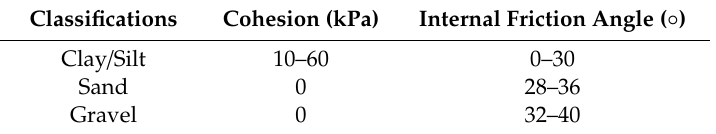
Table 1. Orders of magnitude of soil properties classified by the particle size of embankments